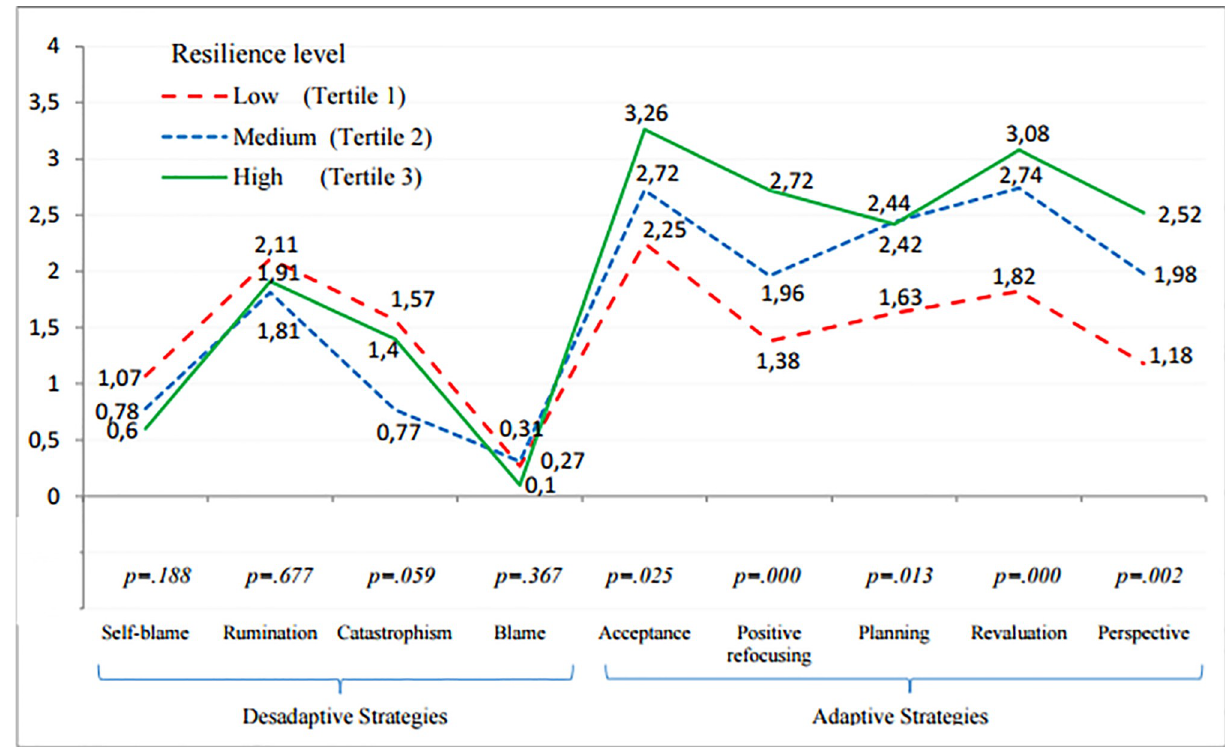
Fig 1. Comparison of means of adaptive and disadaptive coping strategies by resilience tertiles.